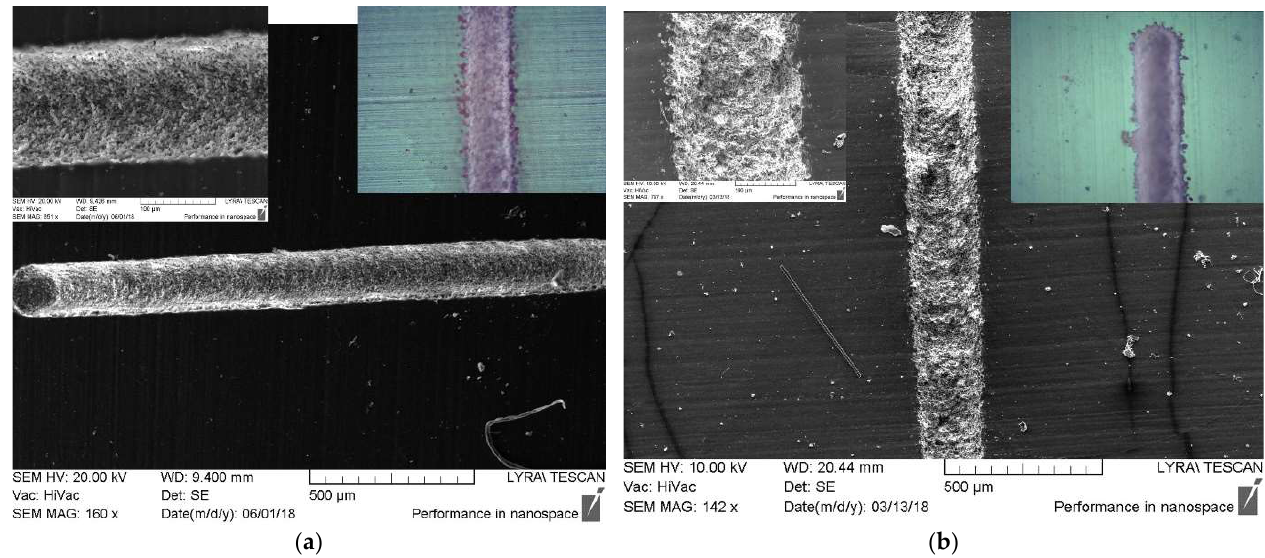
Figure 5. SEM images in different magnifications are applied in order to demonstrate production of free of debris laser tracks after ns-laser ablation of PDMS polymer in water. No evidence of deposition of ejected material and heat-affected zone is observed near the place of ablation. The insets present higher magnification of the SEM images and images taken by optical microscope: ( a ) 266 nm and fluences higher than 28.07 J.cm −2 ; ( b ) 355 nm and fluences higher than 21.75 J.cm −2 .